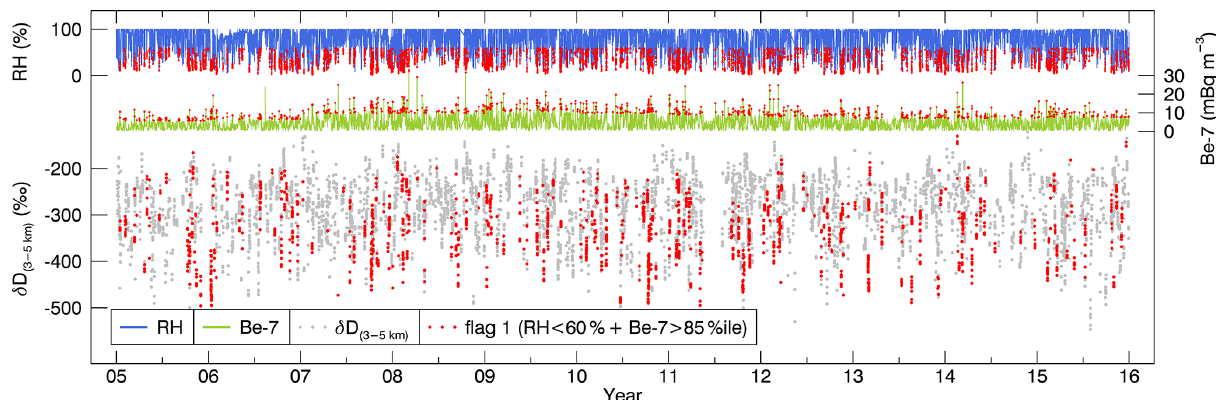
Figure 10. Deep stratospheric intrusions at Zugspitze in 2005–2015 derived from in situ observations of stratospheric tracers (relative humidity and Be-7) using DSTI-flag 1 and coincident FTIR data of lower-tropospheric δ D (deseasonalized hourly means of 3–5km partial columns).